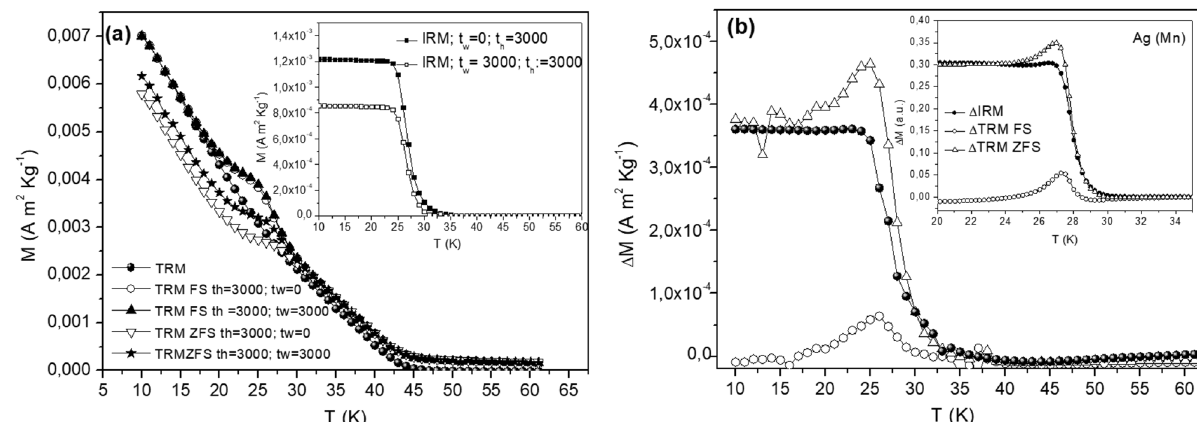
Figure 6. ( a ) TRM magnetization measured after Field Stop (FS) with 10 Oe and Zero Field Stop (ZFS) at 25 K after different waiting (t w ) and halt time (t h ) as defined in the text ; (inset a ) IRM magnetization measured after FS with 10 Oe at 25 K for different t w and t h as defined in the text; ( b ) different between pair of curves reported in ( a ): ΔM IRM, ΔM TRM FS (plotted as − ΔM TRM FS ) and ΔM TRM ZFS (plotted as − ΔM TRM ZFS) for MnFe 2 O 4 (main frame) and the archetypal spin glass Ag(Mn)